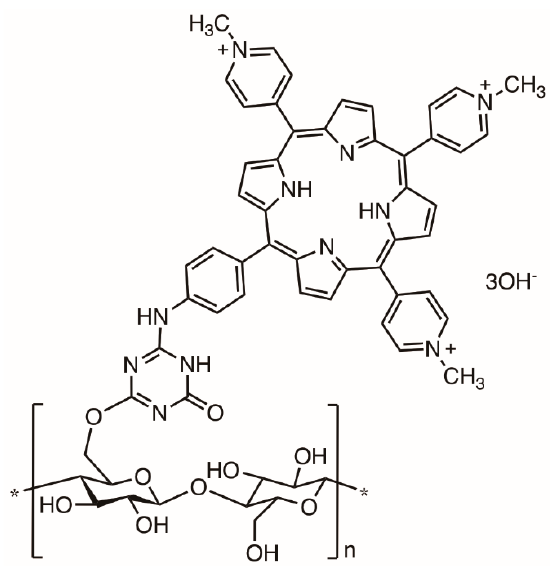
Figure 25. Structure of the antimicrobial filter paper bearing a tricationic porphyrin (adapted from Reference [132]).